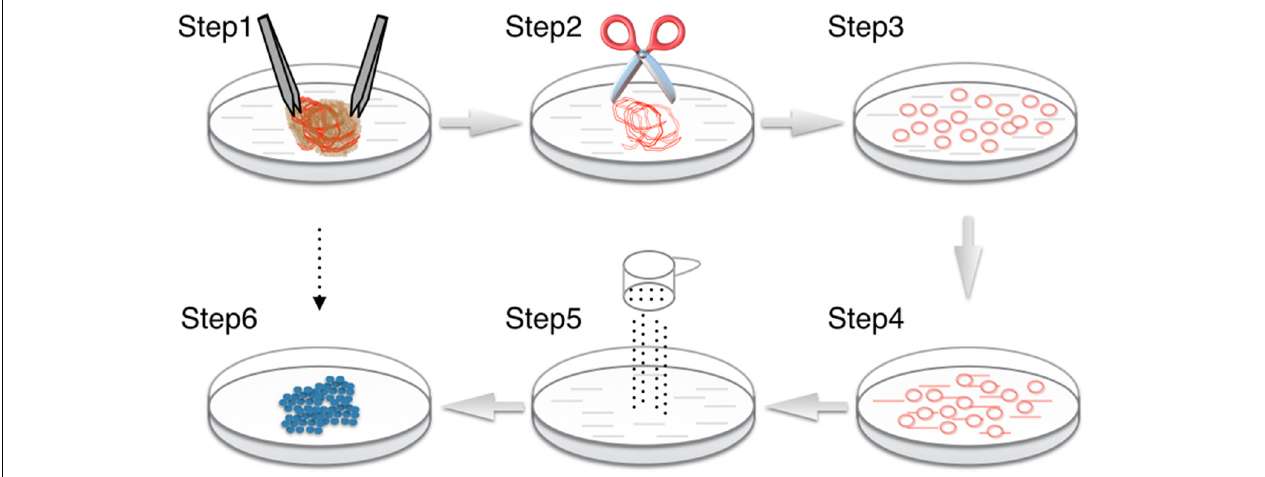
FIGURE 2 | Procedure for cAVM-EC isolation from cAVM lesioned tissues. (Step 1) Separate brain tissue from surrounding vessels; (Steps 2–4) AVMs were cut into small cubes and digested using 0.25% Trypsin-EDTA; (Step 5) filter cells; (Step 6) incubated cells for 7–14 days until colonies